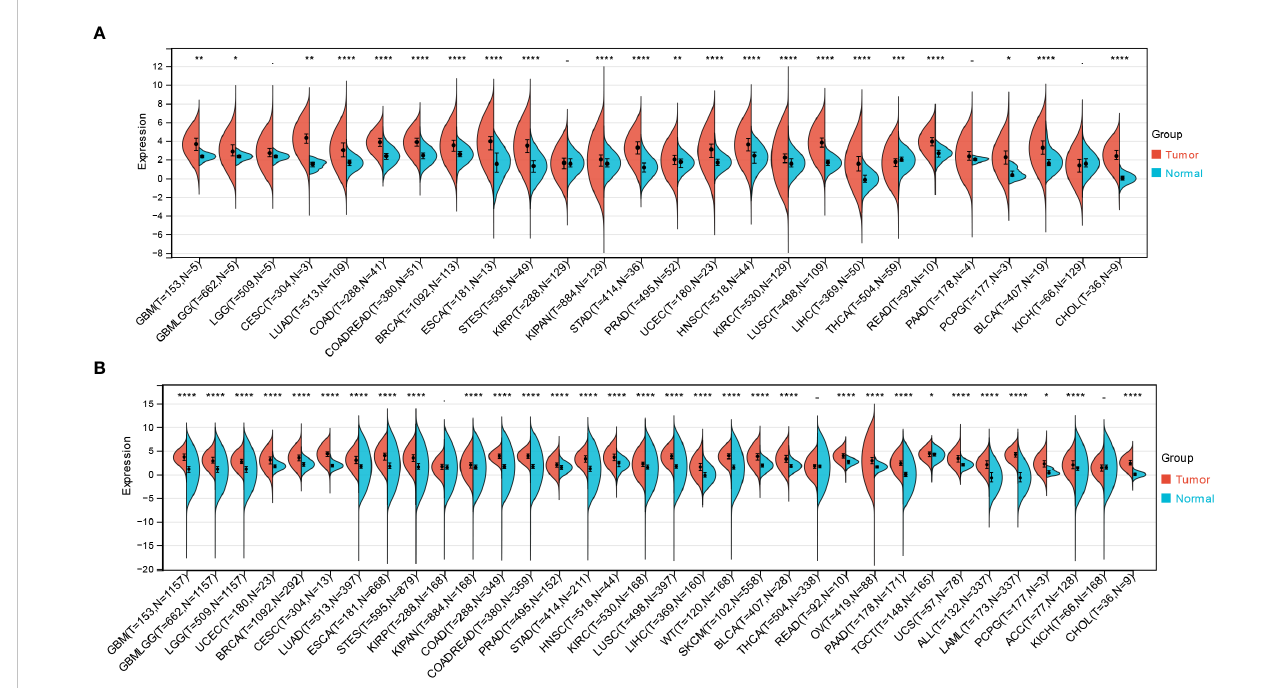
FIGURE 1 Differential expression of NCAPG2 in pan-cancer. (A) Analysis of NCAPG2 expression in matched tumor tissues and normal tissues using data from the TCGA database. (B) Matched analysis comparing NCAPG2 expression differential in TCGA database and GTEx database. Ns, p ≥ 0.05; *p<0.05; **p<0.01; ***p<0.001;